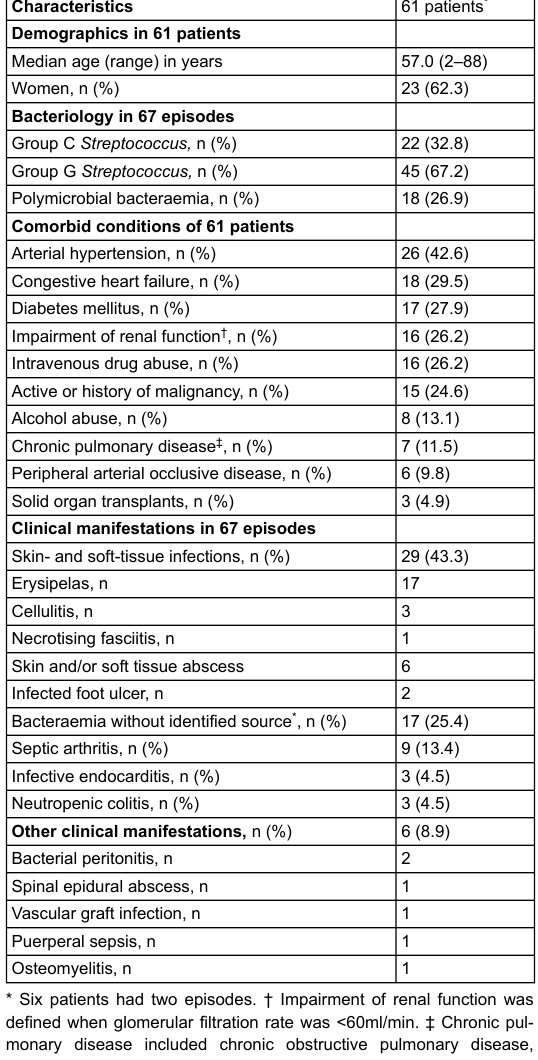
Table 1: Patient characteristics and comorbid conditions in adult pa- tients with Streptococcus dysgalactiae bacteraemia. Characteristics 61 patients